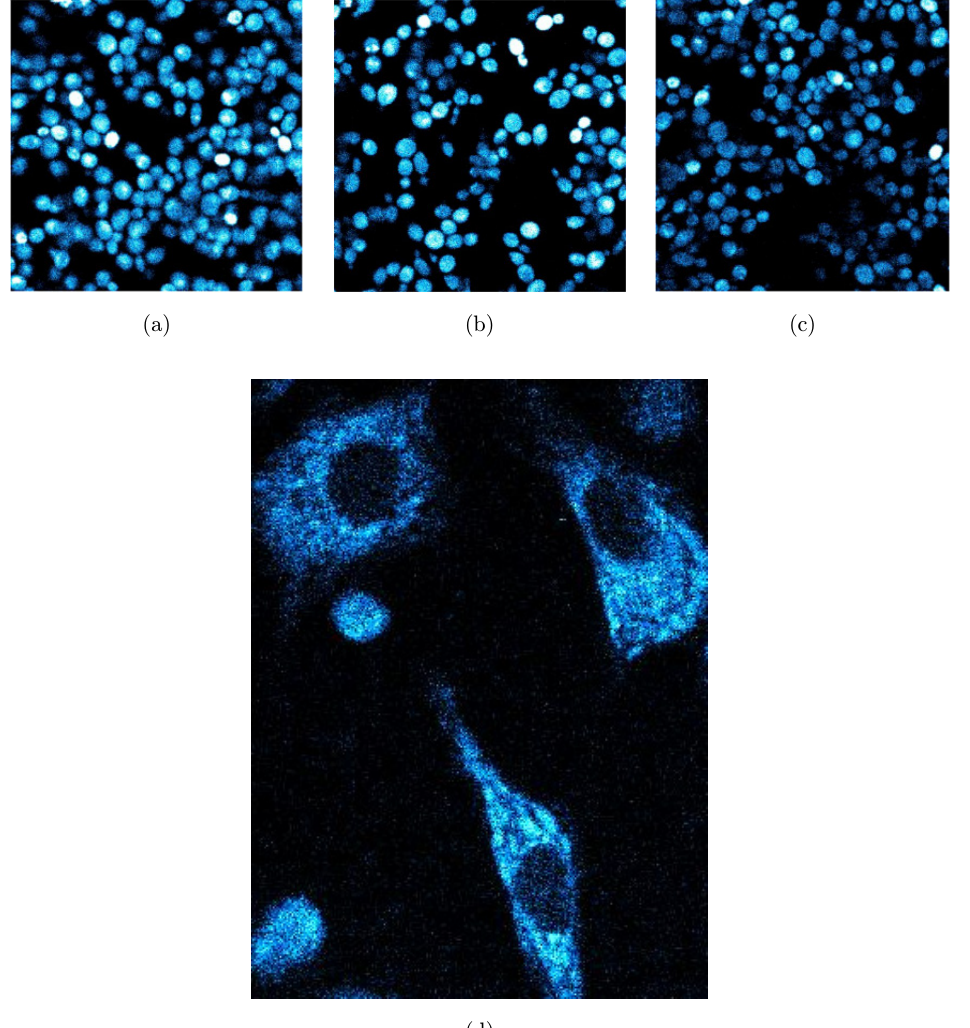
Fig. 5. Two-photon excitation of auto°uorescence (excitation 740 nm, total emission < 490 nm), was almost entirely due to NAD (P)H: in Saccharomyces cerevisiae (a) before and (b) after, electroporation. In (c) and (d) yeast and cardiomyocyte °uorescence after electroporation in the presence of Ru nanoparticles con¯rm continued cellular redox balances. Mild ultrasonic treatment gave permeabilized control cells that showed negligible auto°uorescence under these optical